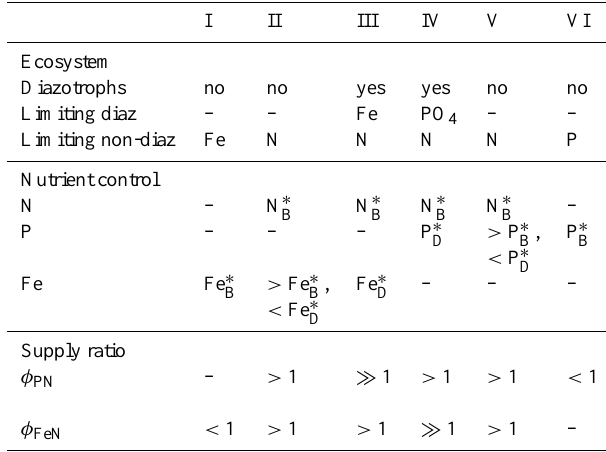
Table 4. Theoretical framework. Equations